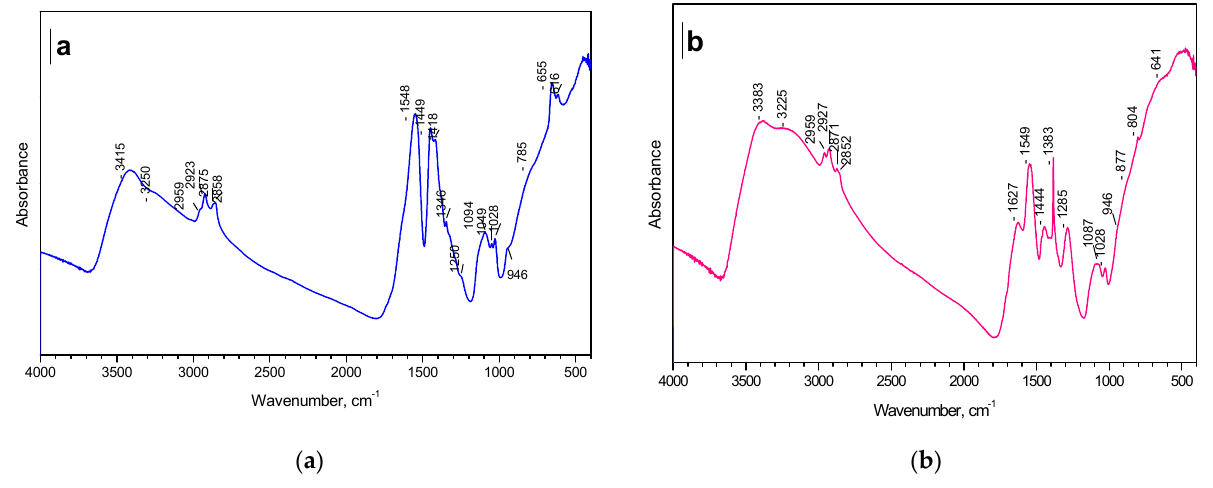
Figure 5. IR spectra of the dried precursor solutions A ( a ) and B ( b ).